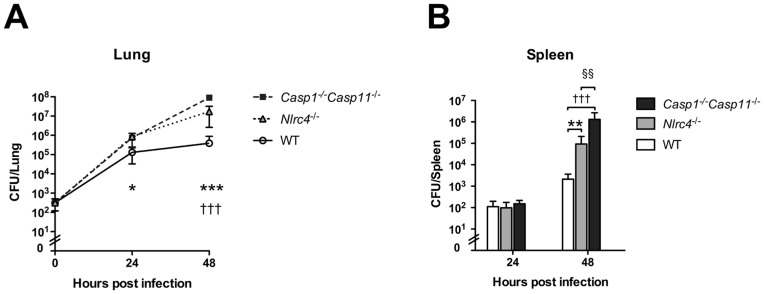

Nlrc4 contributes substantially to Caspase-1/Caspase-11-dependent restriction of B. pseudomallei replication in the lung.Wild type (WT), Nlrc4
−/−, and Casp1
−/−
Casp11
−/− mice were infected with 314 CFU/lung aerosolized B. pseudomallei 1026b. Lungs (A) and spleens (B) were harvested and quantitatively cultured 24 and 48 hours after infection. Data displayed are means ± SD and represent one of two comparable experiments. N = 4 per group per timepoint except N = 3 for Casp1
−/−
Casp11
−/− mice at 24 h. *, p≤0.05, **, p≤0.01, and ***, p≤0.001 for Nlrc4
−/− compared to wild type mice; †††, p≤0.001 for Casp1
−/−
Casp11
−/− compared to wild type mice; §§§, p≤0.001 for Nlrc4
−/− compared to Casp1
−/−
Casp11
−/− mice.